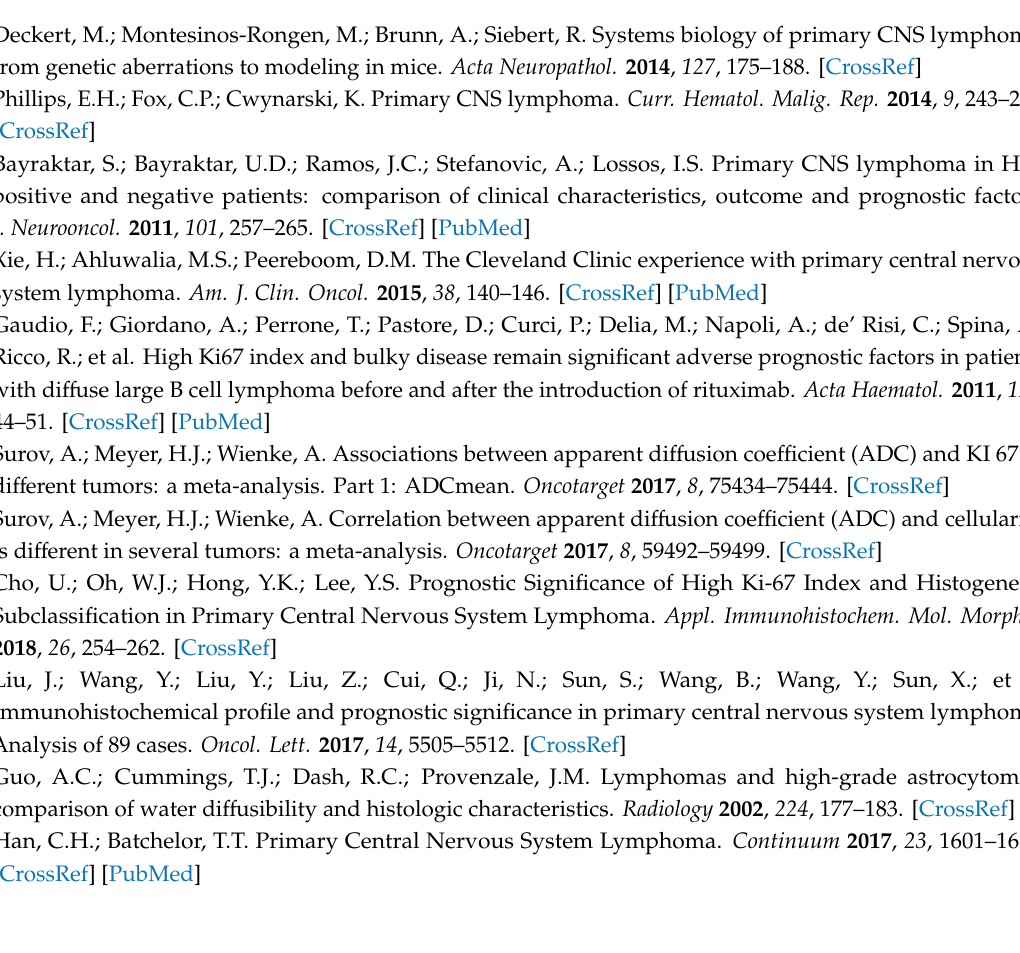
Table S1: Summary of mean values of ADC histogram parameters, Table S2: Correlations of non-normalized ADC values with Ki-67 in patients with available